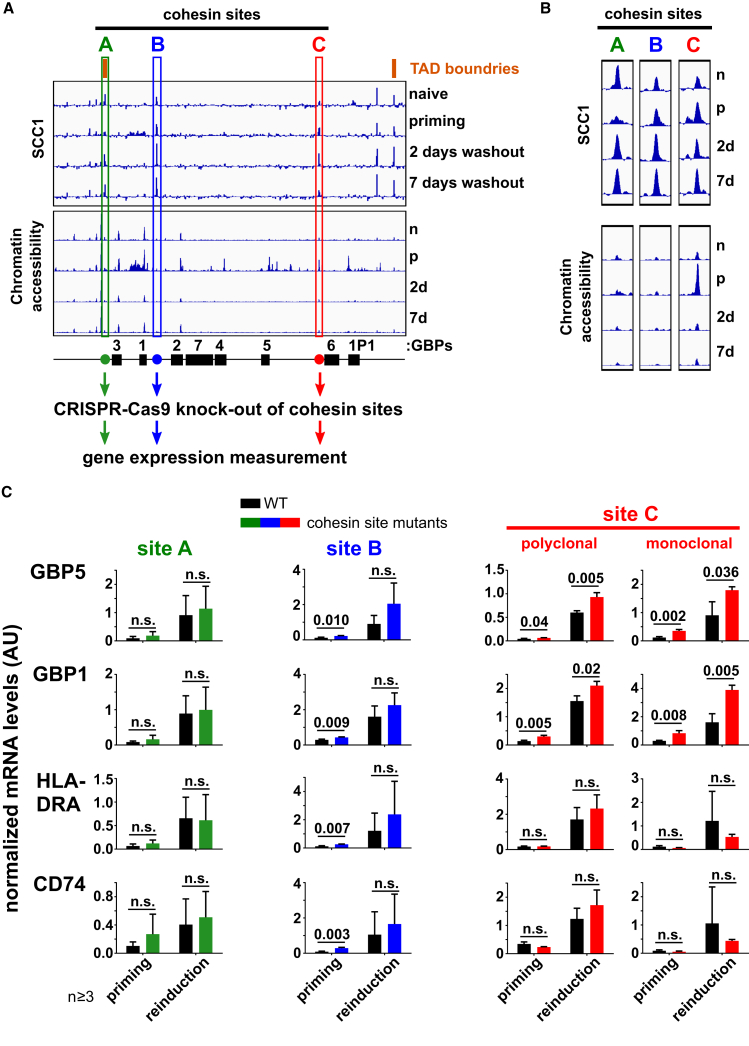
Cohesin Bound at the GBP Cluster Inhibits Establishment of Transcriptional Memory within the Cluster but Not for Distal Genes(A) Representation of processed data for occupancy of SCC1 (ChIPmentation) and chromatin accessibility (ATAC-seq; see also Figure 5C) during the IFNγ long-term memory assay described in Figure 5A. Data are plotted as in Figure 5C. The results are shown for the GBP cluster; TAD boundaries (Figure S5A) and prominent cohesin sites are indicated.(B) Enlarged presentation of three selected cohesin sites.(C) Approximately 1-kb regions encompassing cohesin-bound sites boxed as A, B, and C in (A) were deleted by CRISPR-Cas9. Two independent polyclonal populations were generated for site A, single polyclonal populations for sites B and C, and a monoclonal clone for site C. Mutant cells were subjected to the transcriptional memory experiment outlined in Figure 1B. mRNA levels were quantified by RT-qPCR for the indicated genes and normalized to ACTB expression. Error bars, SD; n = 3 (n = 6 for site A) biological replicates. n.s., non-significant (p > 0.05).See also Figure S7.